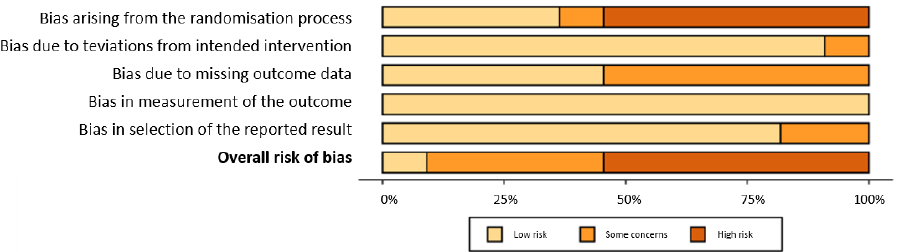
Figure 2. Risk of bias summary: reviewing authors ’ judgements about each risk of bias item for each included study.